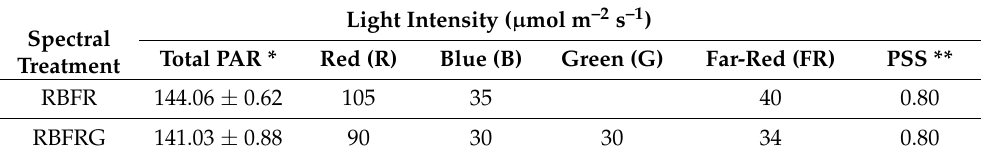
Table 2. The measured total PAR (400–700 nm) and set-points PFD (400–800 nm) of blue (B; 400–500 nm), green (G; 500–600 nm), red (R; 600–700 nm), and far-red (FR; 700–800 nm) light and the PSS for the two spectral treatments in Experiment